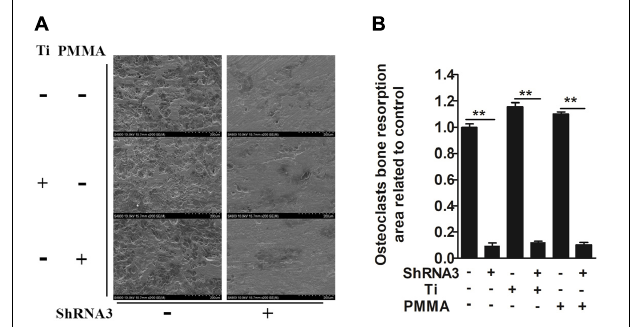
FIGURE 2 | Role of SLC4A2 in wear particle-induced osteoclast function. Equal numbers of osteoclasts were seeded onto bone slices, allowed to adhere to the surface, and treated with 30 ng/mL M-CSF, 100 ng/mL RANKL, and the indicated treatment. (A) Knockdown of SLC4A2, using shRNA3, on wear particle-induced osteoclastic bone resorption in vitro . Representative scanning electron microscopy (SEM) images of bone-resorption pits are shown. (B) The total area of resorption pits, measured using ImageJ ( ∗ P < 0.05; ∗∗ P < 0.01). At least three independent replicated of each experiment were conducted